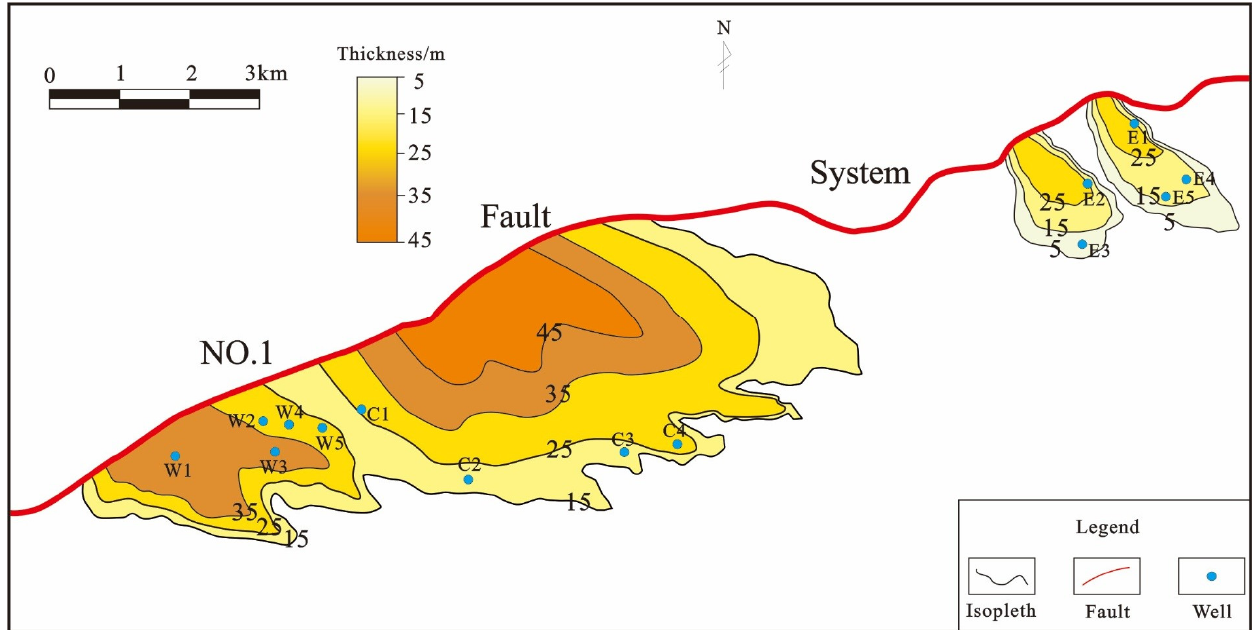
Figure 13. Average sandstone thickness in different areas of the Liushagang Formation in the northern steep-slope zone of the Weixinan Sag (with an average of 40 m in the west, 25 m in the middle, and 20 m in the east).